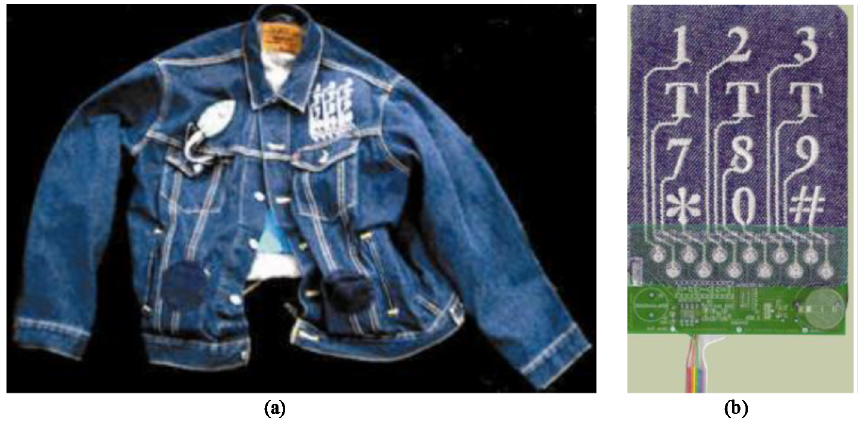
Figure 18. ( a ) Musical jacket. ( b ) Fabric keypad with circuit board placed behind it